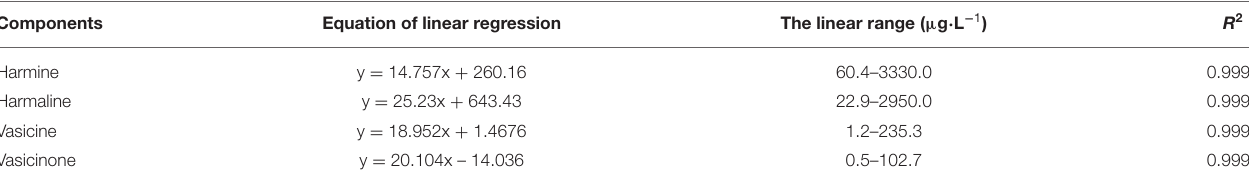
TABLE 1 | Linear regression equations, linear range, and correlation coefficients for the four alkaloids. Components Equation of linear